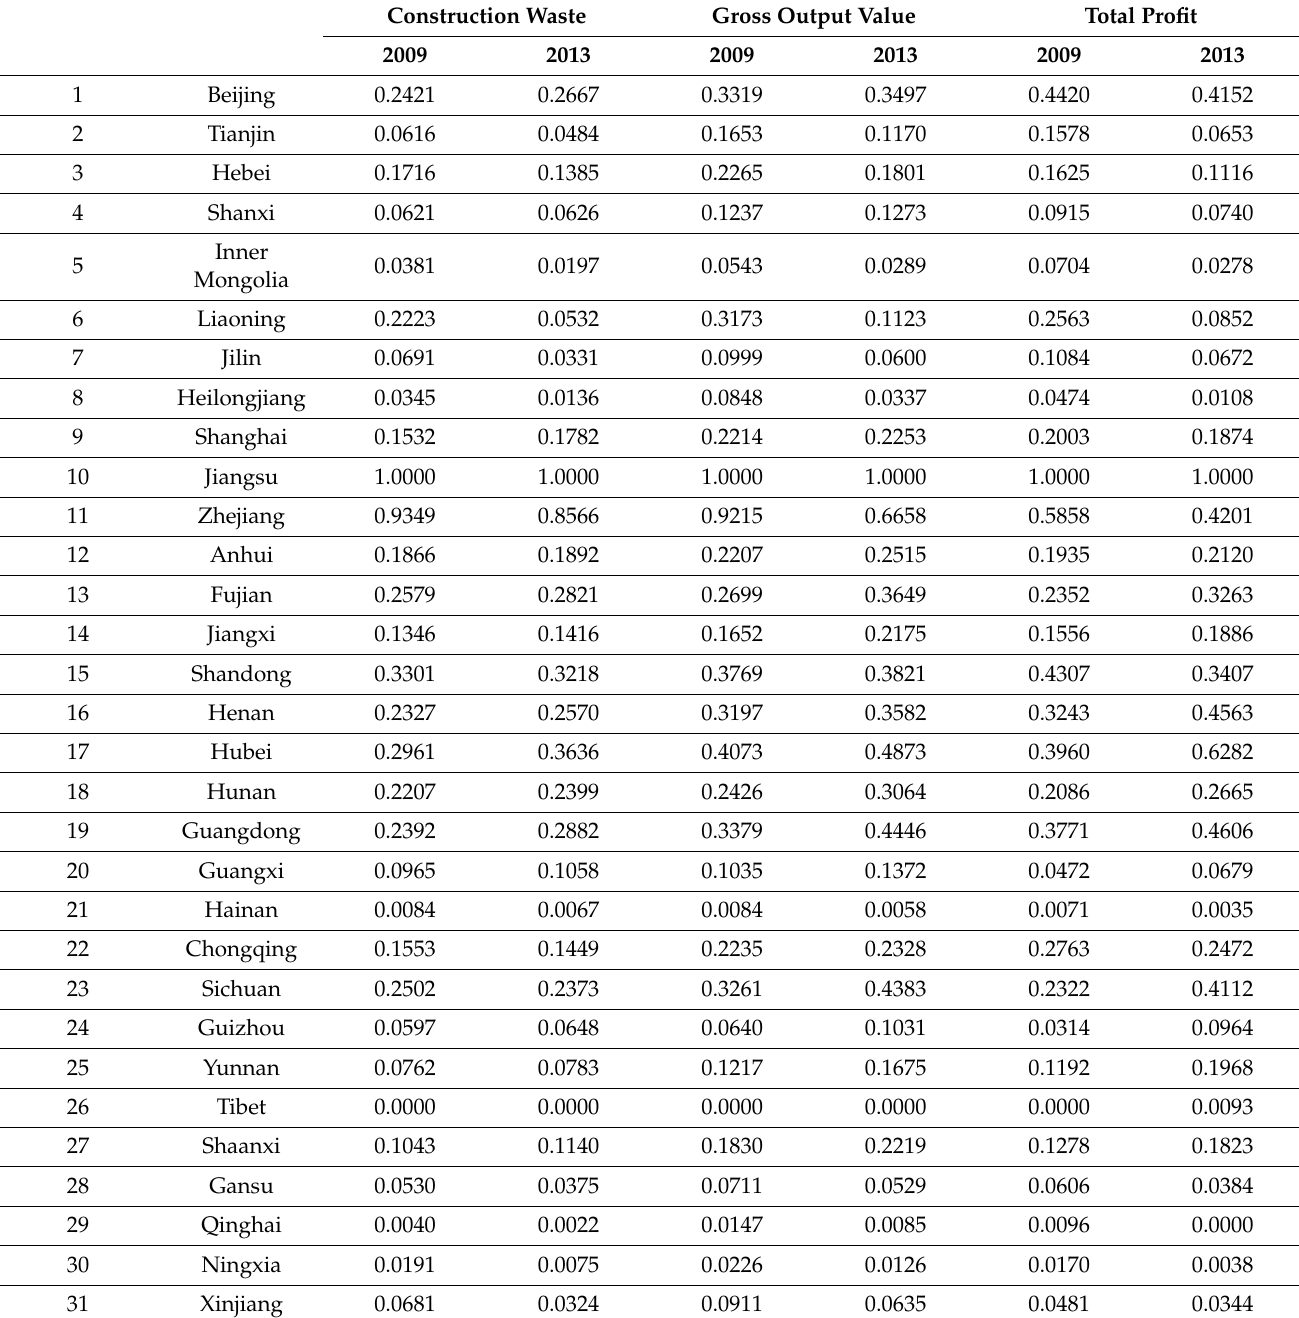
Table A4. Standardized and normalized raw data in 2014 and